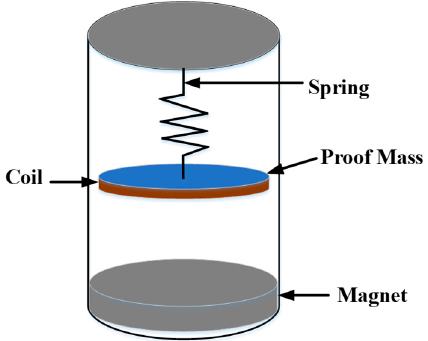
Figure 4. An electromagnetic energy regenerative suspension (Reproduced and drawn with permission from Ref. [10]).